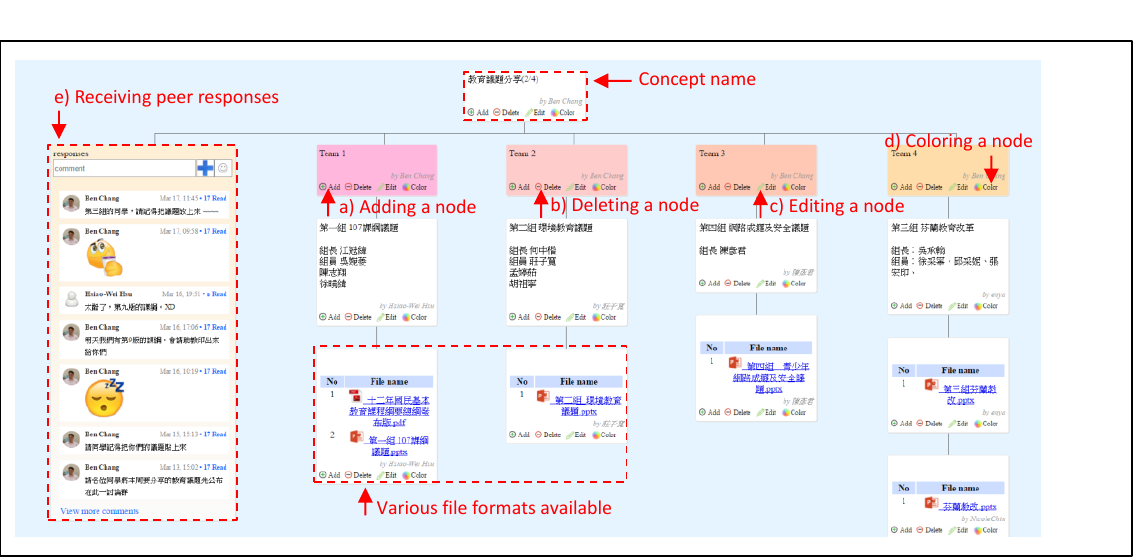
Figure 2. Co-construction concept building function